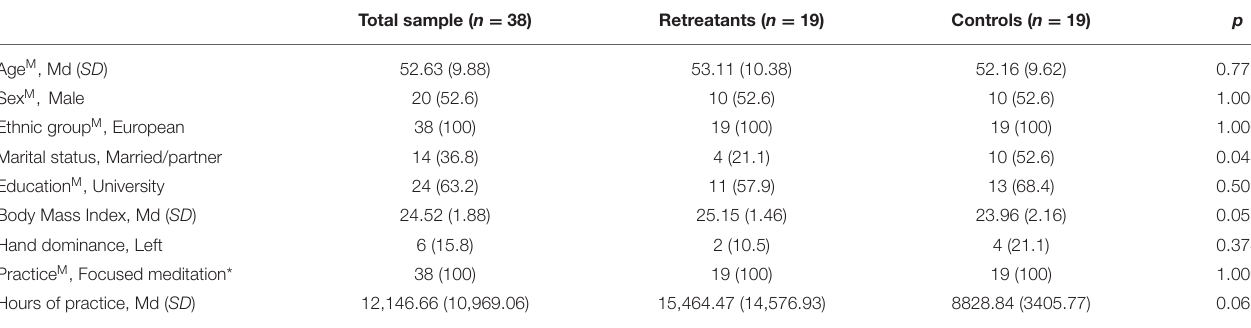
TABLE 1 | Characteristics of study